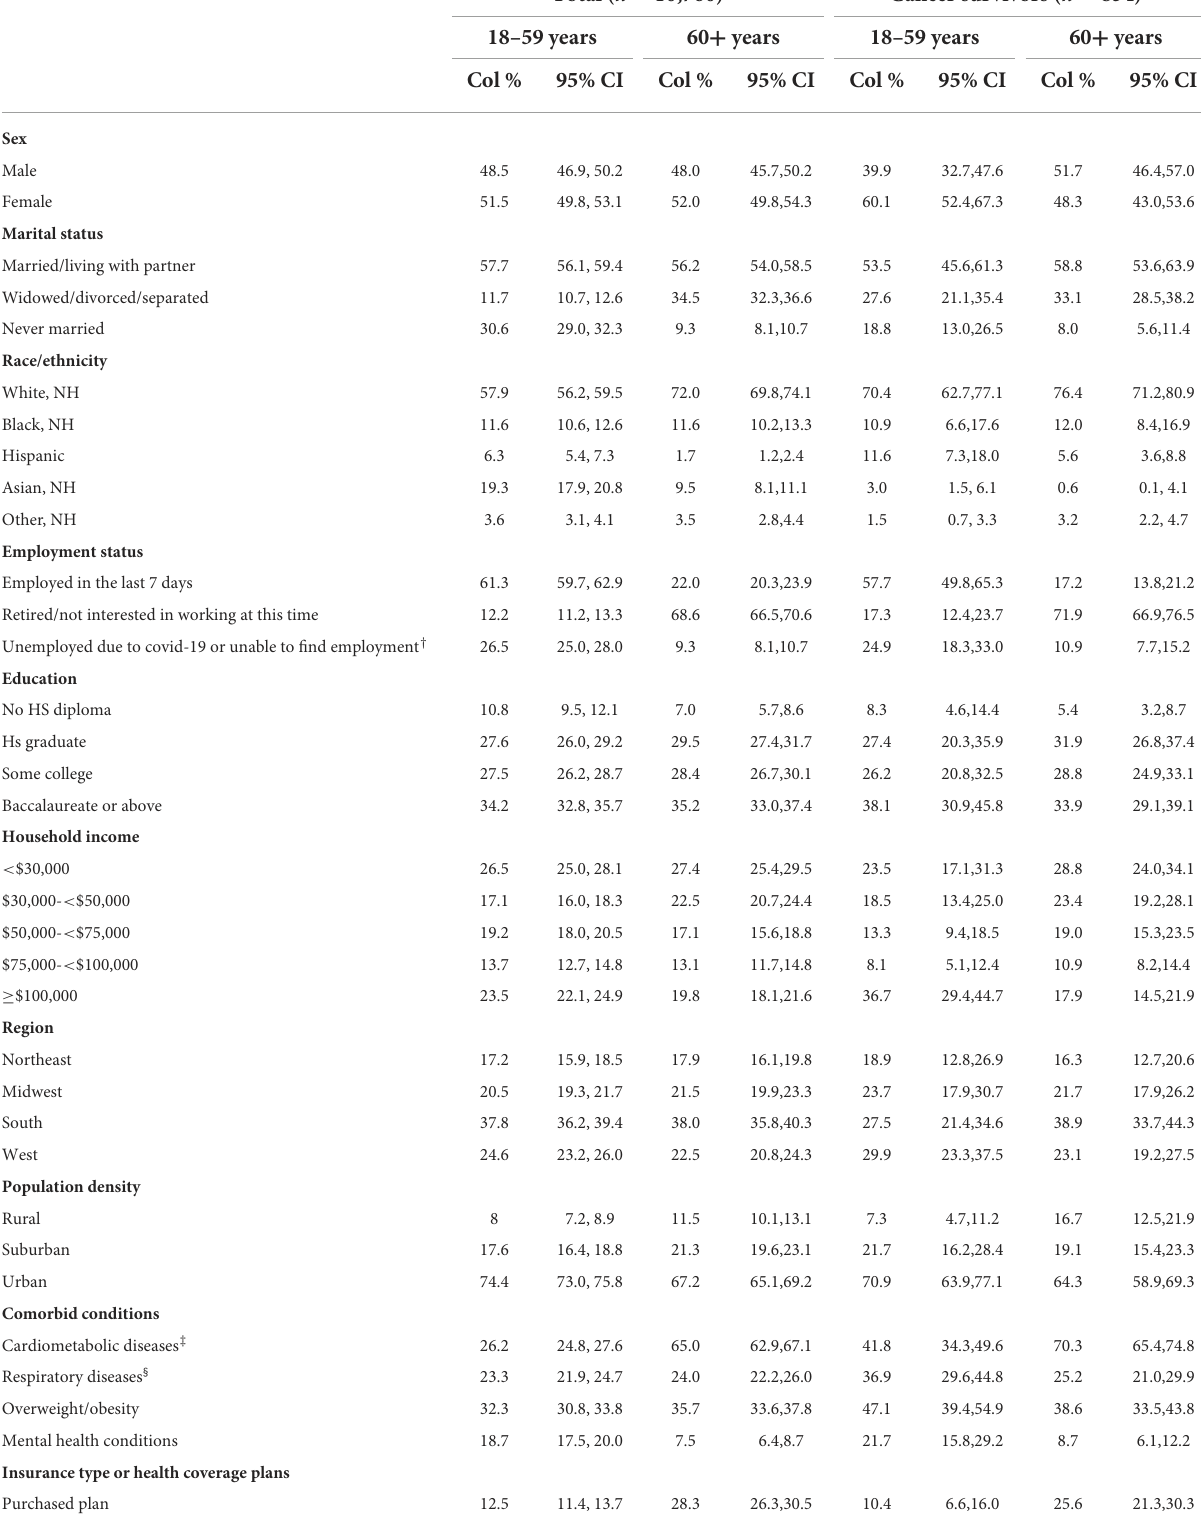
TABLE 1 Characteristics of COVID Impact Survey respondents ( n = 10,760), a nationally representative survey of the US, stratified by cancer diagnosis (April-June